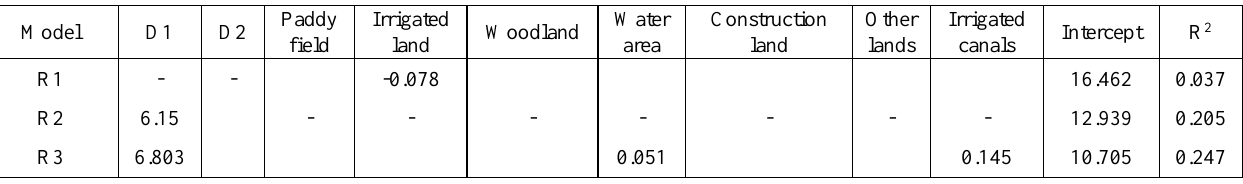
Table 3. Association between SOC content, land use types and percentages R1: stepwise regression with land use percentages; R2: stepwise regression with land use types; R3: stepwise regression with land use types and percentages; Void coefficients denote not significant (p>0.05).